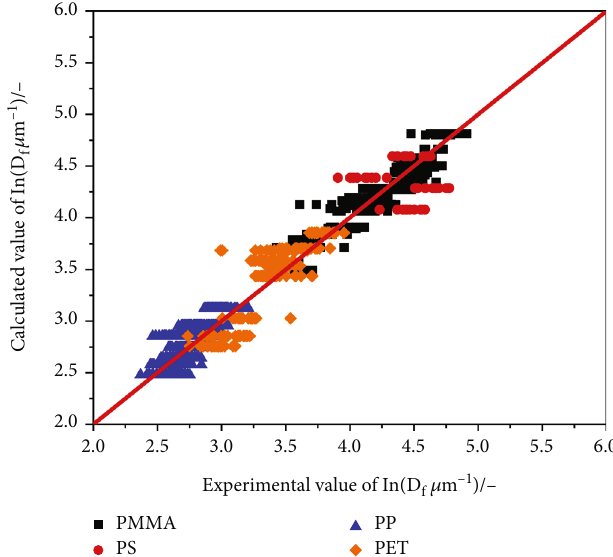
Figure 10: Comparison of predicted and experimental fi bre diameters using the linear regression model with the exact output parameter values, utilising a capillary rheometer combined with an